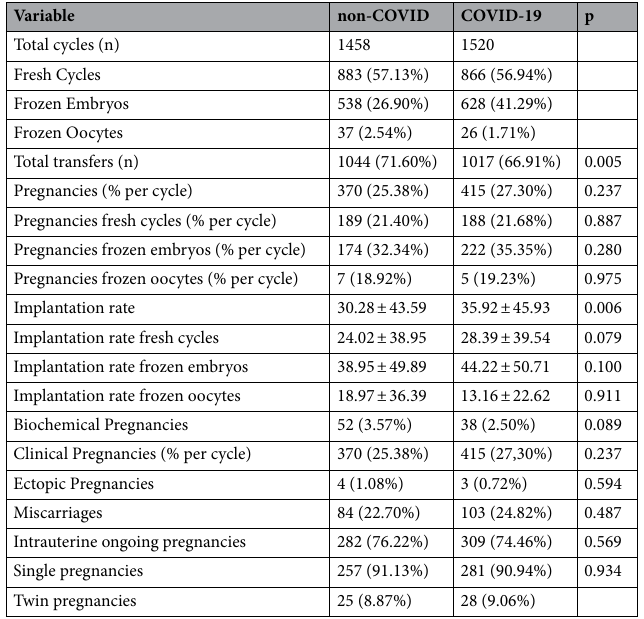
Table 3. Summary ART cycles outcome in the total population during pre COVID and COVID-19 timeframes.